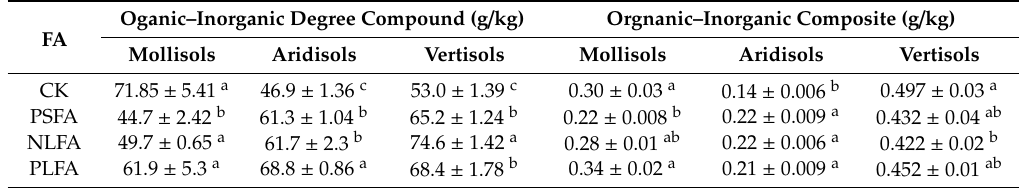
Values are the means ± standard error ( n = 4) for PSFA (plant-derived solid fulvic acid), NLFA (mineral-derived liquid fulvic acid), and PLFA (plant-derived liquid fulvic acid). Di ff erent letters (a, b, and c) indicate significant di ff erences between the soils ( p <